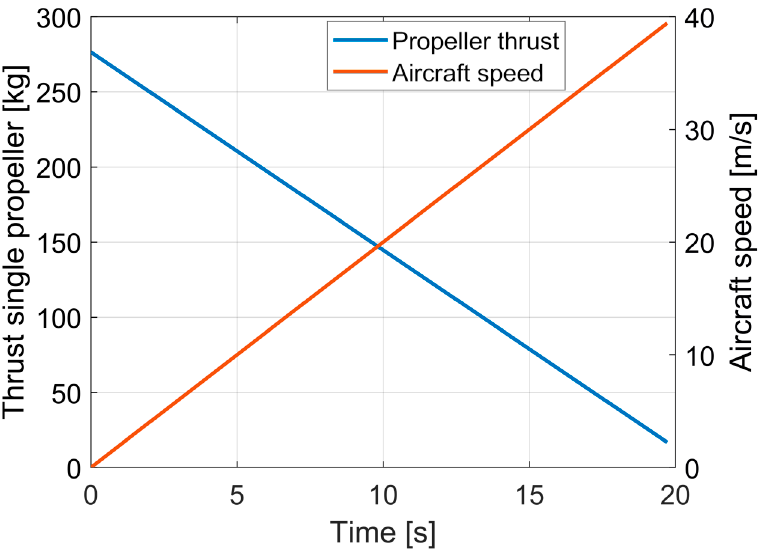
Figure 7. Propeller thrust and aircraft speed during transition.